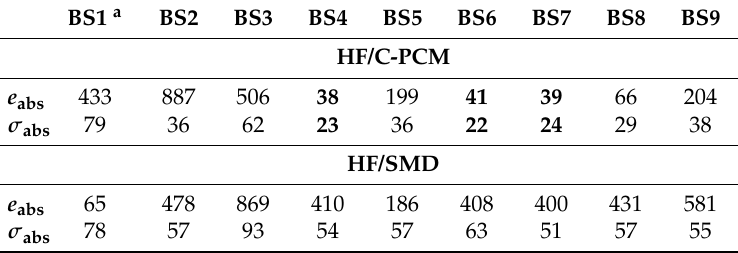
Table 1. Mean absolute errors ( e abs ) and standard deviation of absolute errors ( σ abs ) for theoretical values of 12 investigated nitroaromatic Morita–Baylis–Hillman adducts (MBHA) calculated at Hartree–Fock (HF) level with C-PCM and SMD continuum solvation models from direct protocol. Values in